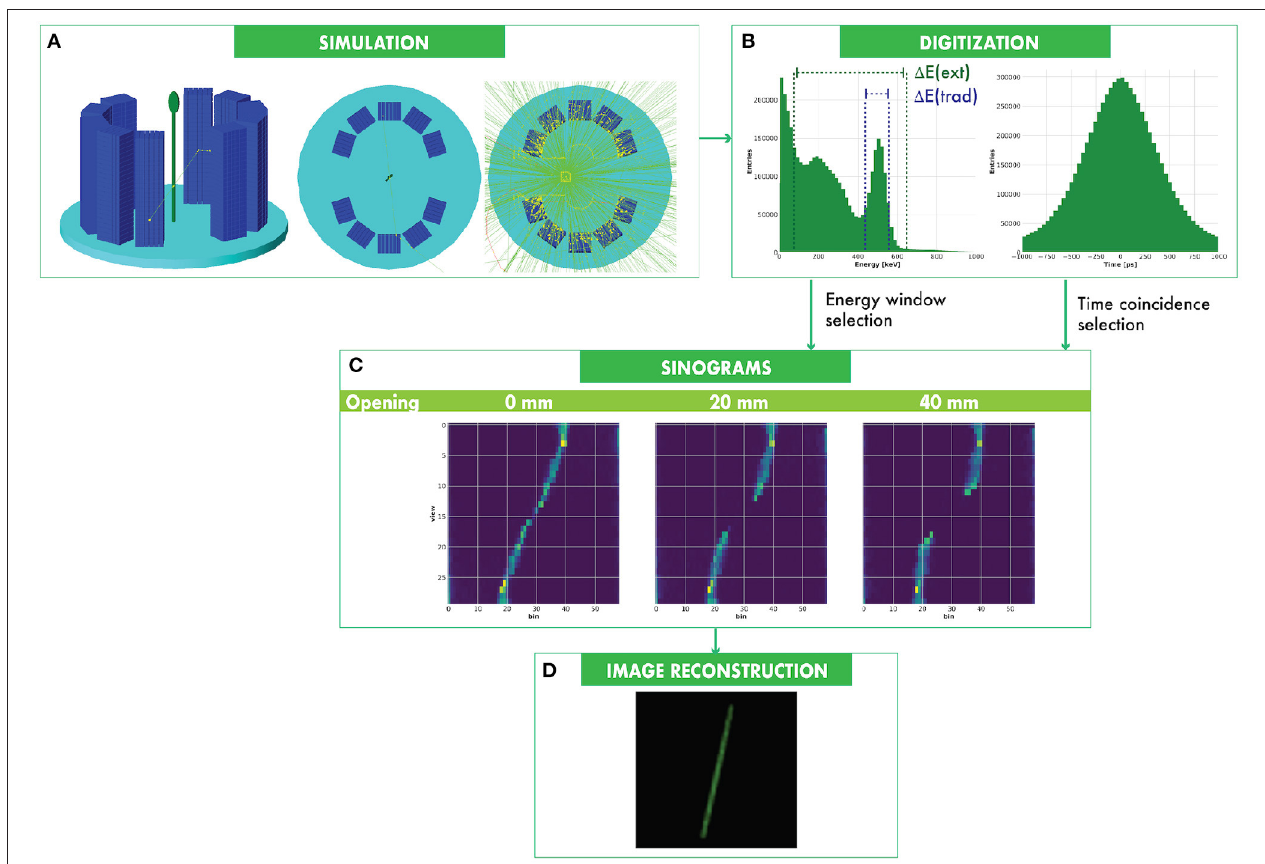
FIGURE 2 | Plant PET simulation and data processing. A plant phantom is placed inside the FOV. A β + emitter in the phantom is simulated. Two γ -rays are generated from the positron annihilation and are detected in the PET sensors (A) . The energy deposited in each PET sensor and the detection time are used to discriminate coincident events (B) , which are ordered in the sinograms (C) . 3D images of the distribution of the radioactive source in the phantoms are reconstructed from the sinograms (D)